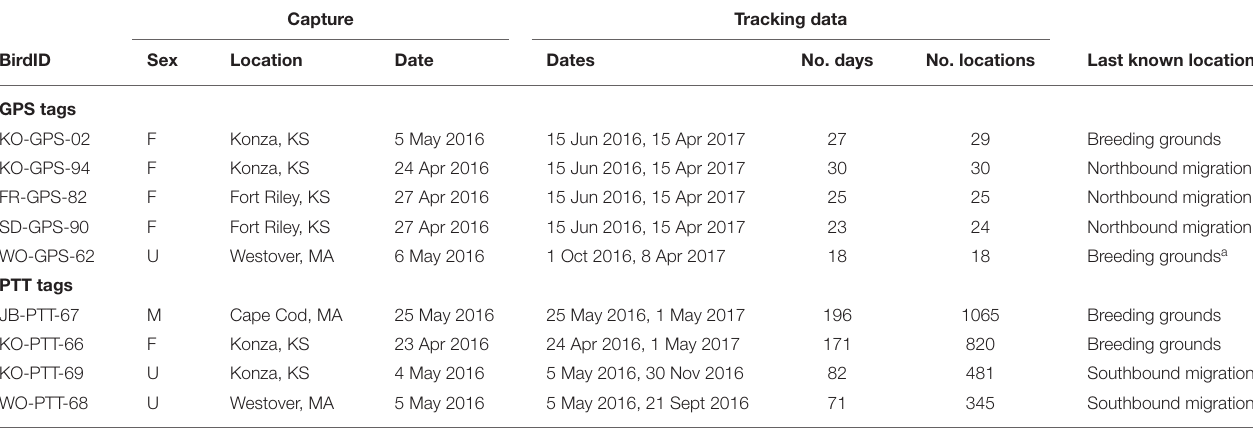
TABLE 1 | Summary of movement data and status of Upland Sandpipers monitored with PinPoint GPS Argos tags (GPS tags), and solar-powered Argos Platform Transmitter Terminals (PTT tags) from 24 April 2016 until 1 May 2017. Capture Tracking